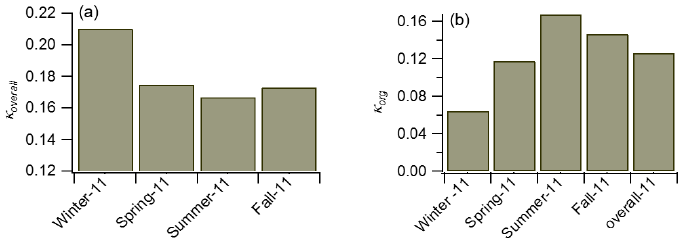
Figure 3. Seasonal profile of ( a ) κ overall (left) and ( b ) κ org (right) in 2011.